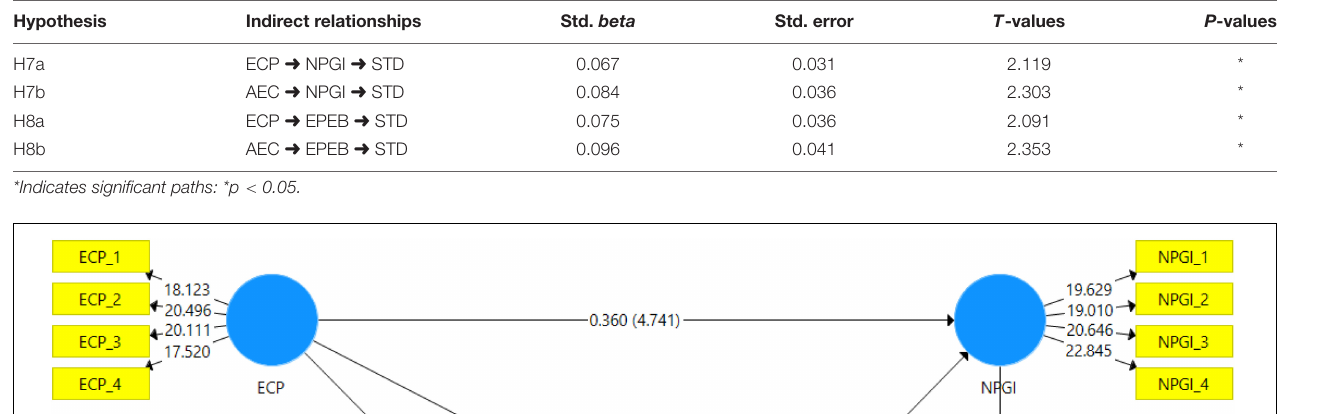
TABLE 6 | Hypotheses testing mediation effect.